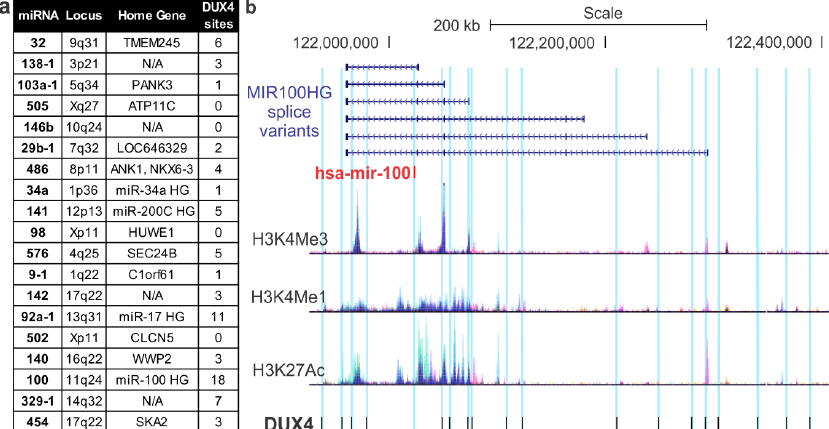
Figure 1. DUX4 binding sites at loci surrounding miRNAs dysregulated in FSHD patients. The 19 miRNAs dysregulated in FSHD1 patient plasma samples were queried for potential regulation by the DUX4 transcription factor, which aberrantly expressed in FSHD, using a DUX4 ChIP-seq dataset [9]. ( a ) Overview of all DUX4 binding sites within regions capable of acting as regulatory elements (100 kb) of the 19 miRNAs and their home genes. ( b ) Schematic of DUX4 binding sites within the miR-100 locus and its surrounding home gene ( MIR100HG ) variants. Note, miR-100 is transcribed from right to left on this image. Corresponding epigenetic modification maps display the location of histone modifications associated with active promoters (H3K4me3) and poised/active enhancers (H3K4me1 and H3K27Ac, respectively).